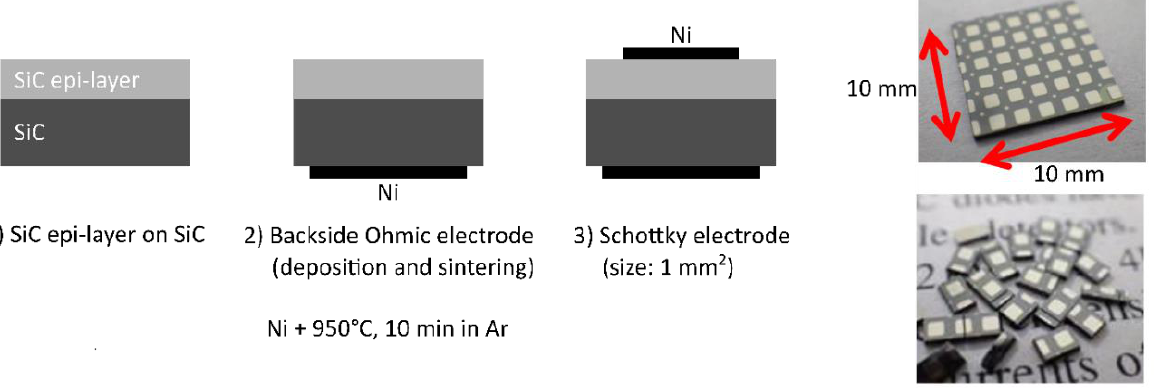
Figure 1: Schematic representation of the manufacture process of 4H-SiC Schottky Barrier Diodes used as neutron